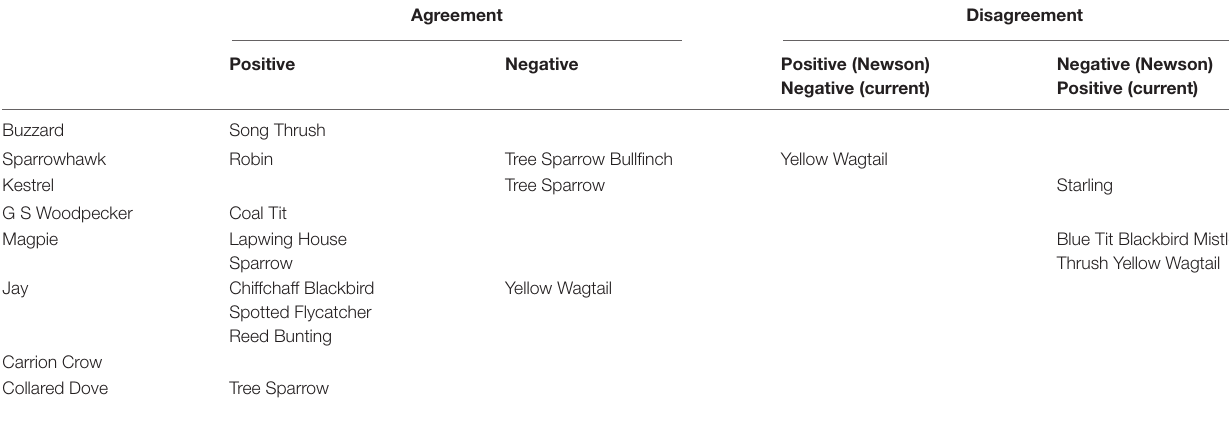
TABLE 6 | Correspondence of significant predator effects in Newson et al. (2010) and current